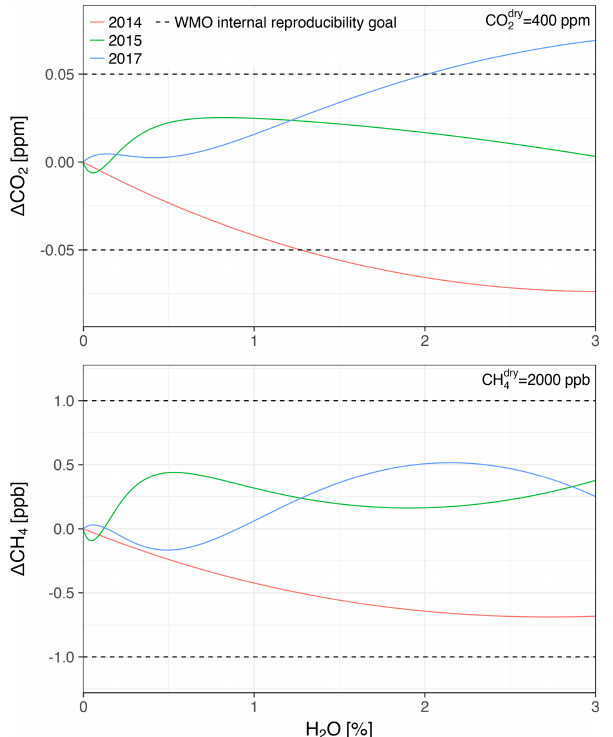
Figure 4. Differences between individual water correction func- tions and the synthesis water correction function at dry air mole fractions of 400ppmCO 2 and 2000ppbCH 4 . The dashed lines cor- respond to the WMO internal reproducibility goals, in the case of CO 2 in the Northern Hemisphere (WMO, 2016).